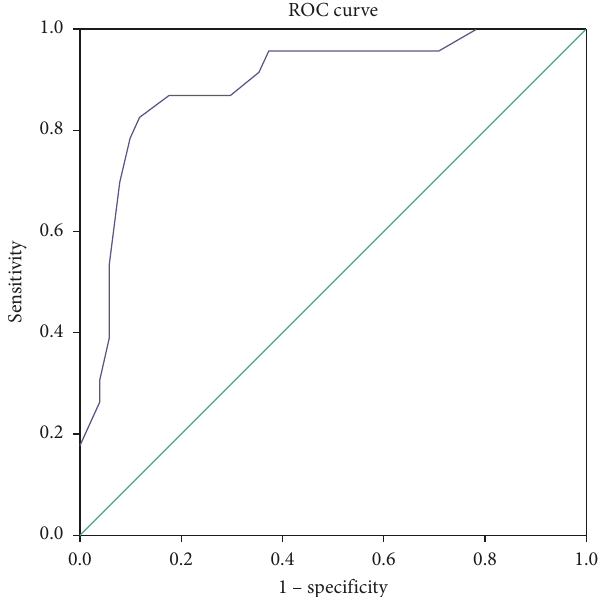
Figure 1: Receiving operating characteristic curve.